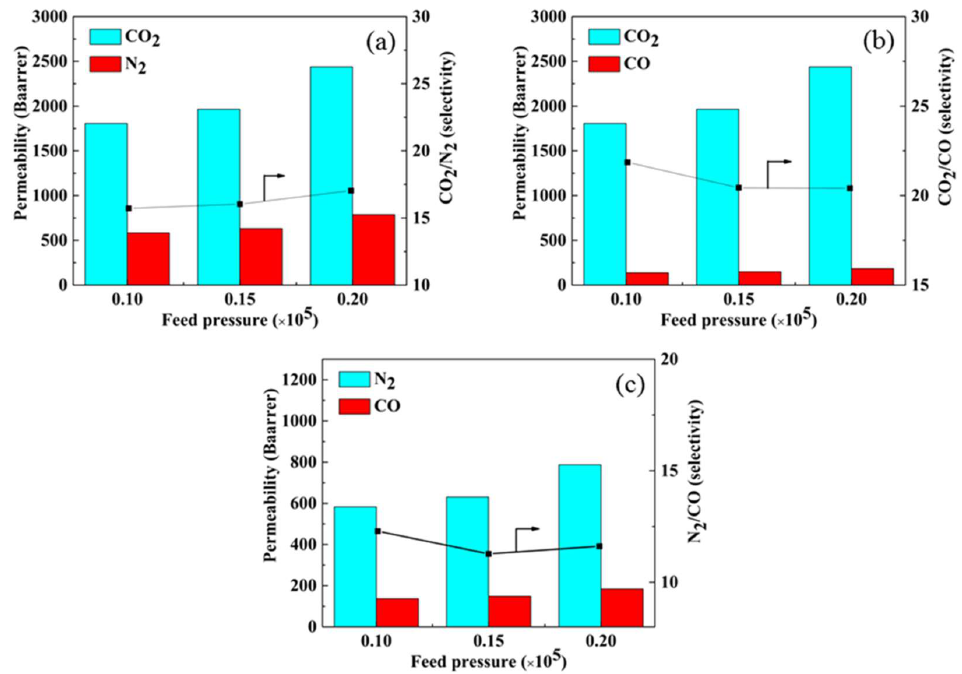
Figure 11. Gas selectivity of Pebax/GO/SWCNTs MMMs for mixed gas (N 2 60%, CO 2 20%, N 2 20%), ( a ) CO 2 /N 2 , ( b ) CO 2 /CO, ( c ) N 2